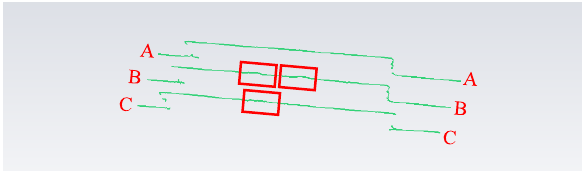
Figure 4. Section results with ice detection